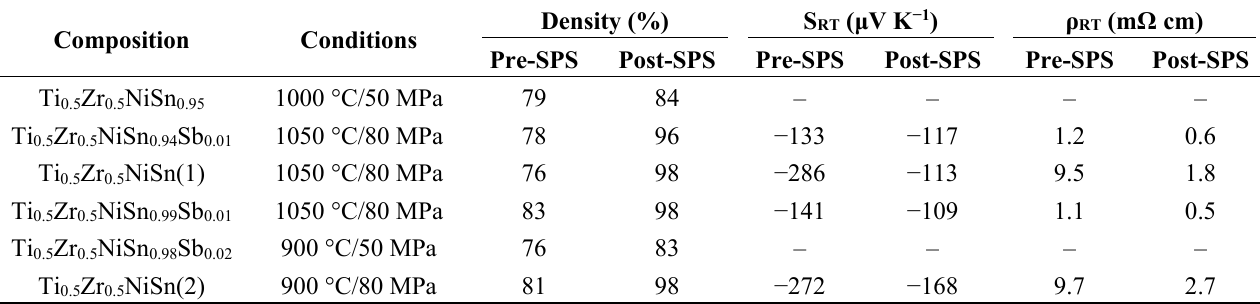
Table 1. Spark plasma sintering (SPS) conditions, pre- and post-SPS densities, and room temperature Seebeck (S) and resistivity (ρ) values for the Ti 0.5 Zr 0.5 NiSn 1/0.95−y Sb y samples. Composition Conditions